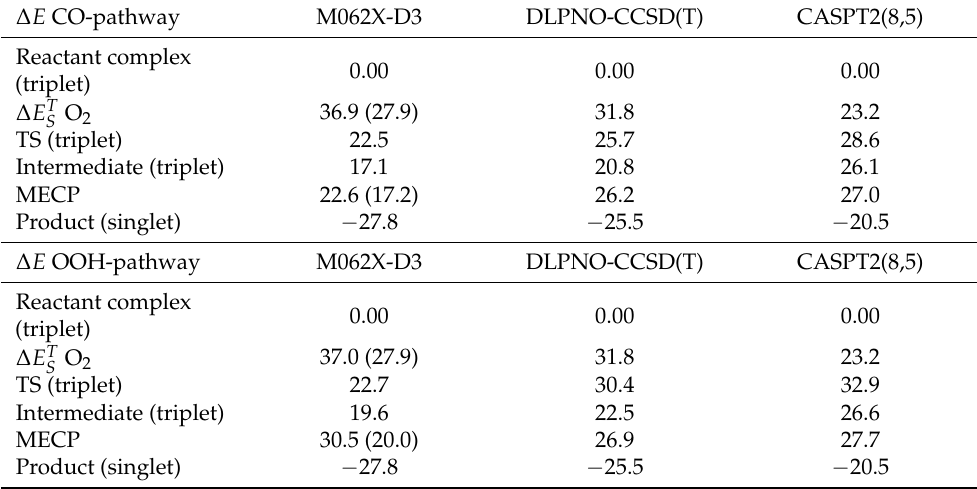
Table 1. Electronic energies of critical points along the reaction paths for the different methods used: M062X-D3 (with broken symmetries in parentheses), CASPT2(8,5), and DLPNO-CCSD(T),